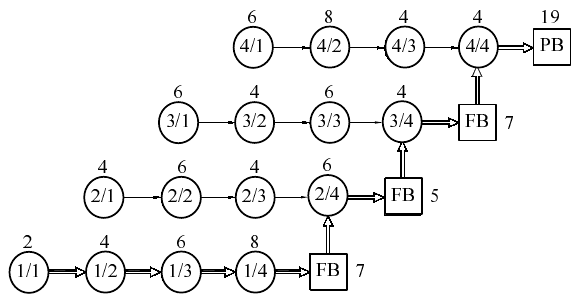
Fig 10. Network of dependences incorporating time buffers